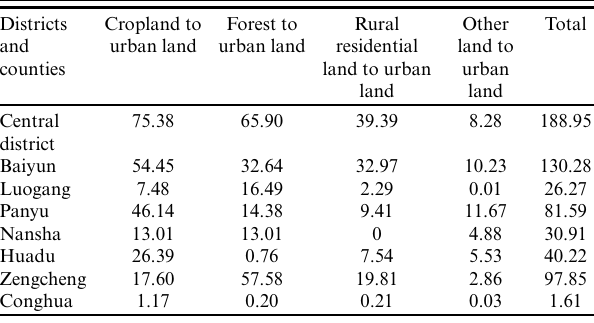
Table 2 . The projected conversion of cropland, forest, rural residential land, and other land to urban land between 2005 and 2020 in Guangzhou